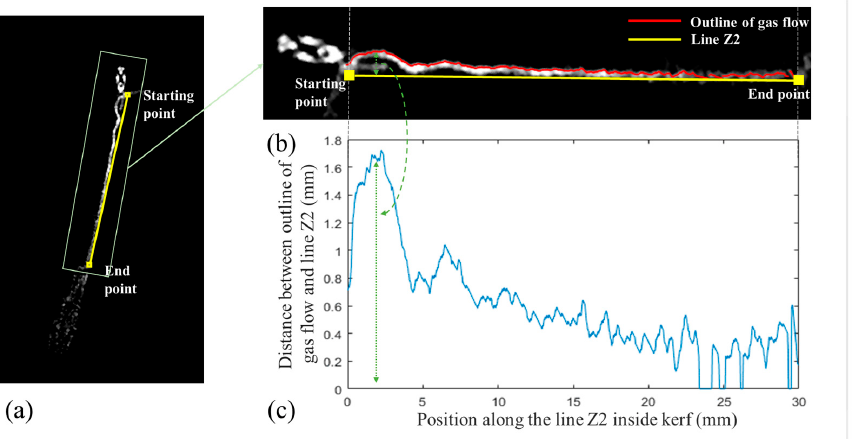
Figure 16. Outline of the flow along the kerf. ( a ) Starting and end points of cut kerf, ( b ) result of image processing for edge detection, ( c ) distance between Schlieren edge and line Z2.